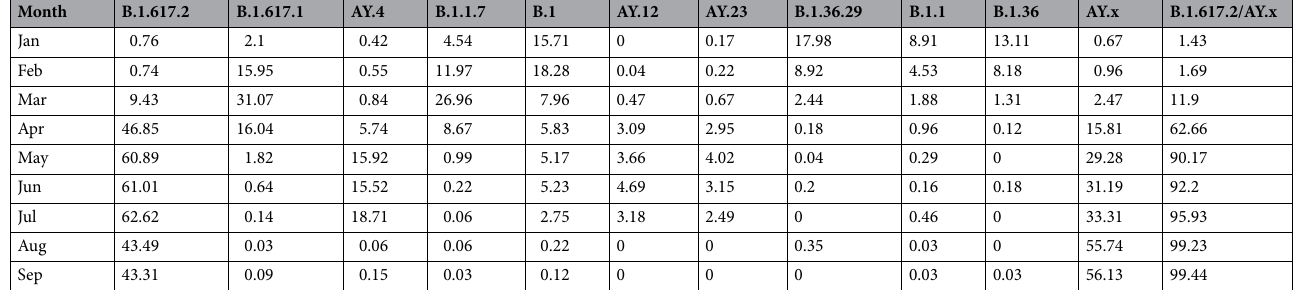
Table 1. Incidences of reported cases of various VoCs per month. The number denotes the percentage incidences of respective Voc with respect to total incidences of the indicated months.